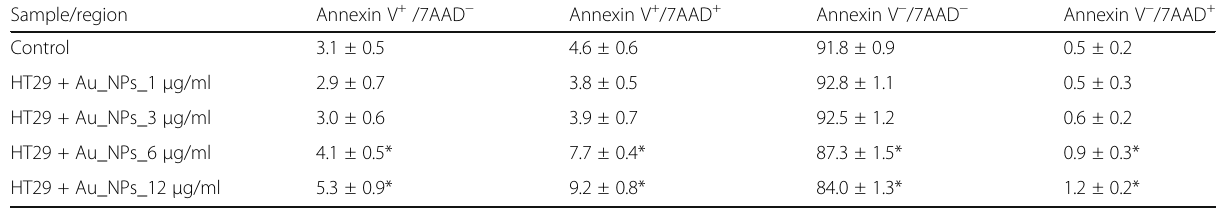
Table 2 Cytofluorimetric analysis of HT29 cells after 4 days culturing with AuNPs, staining with Annexin V and 7AAD